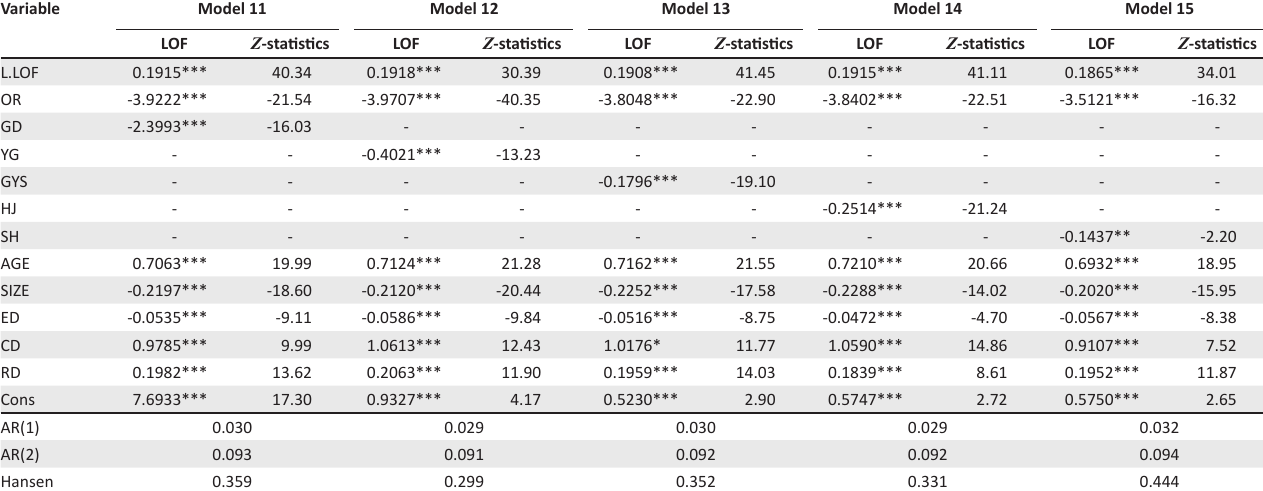
TABLE 5: Robustness